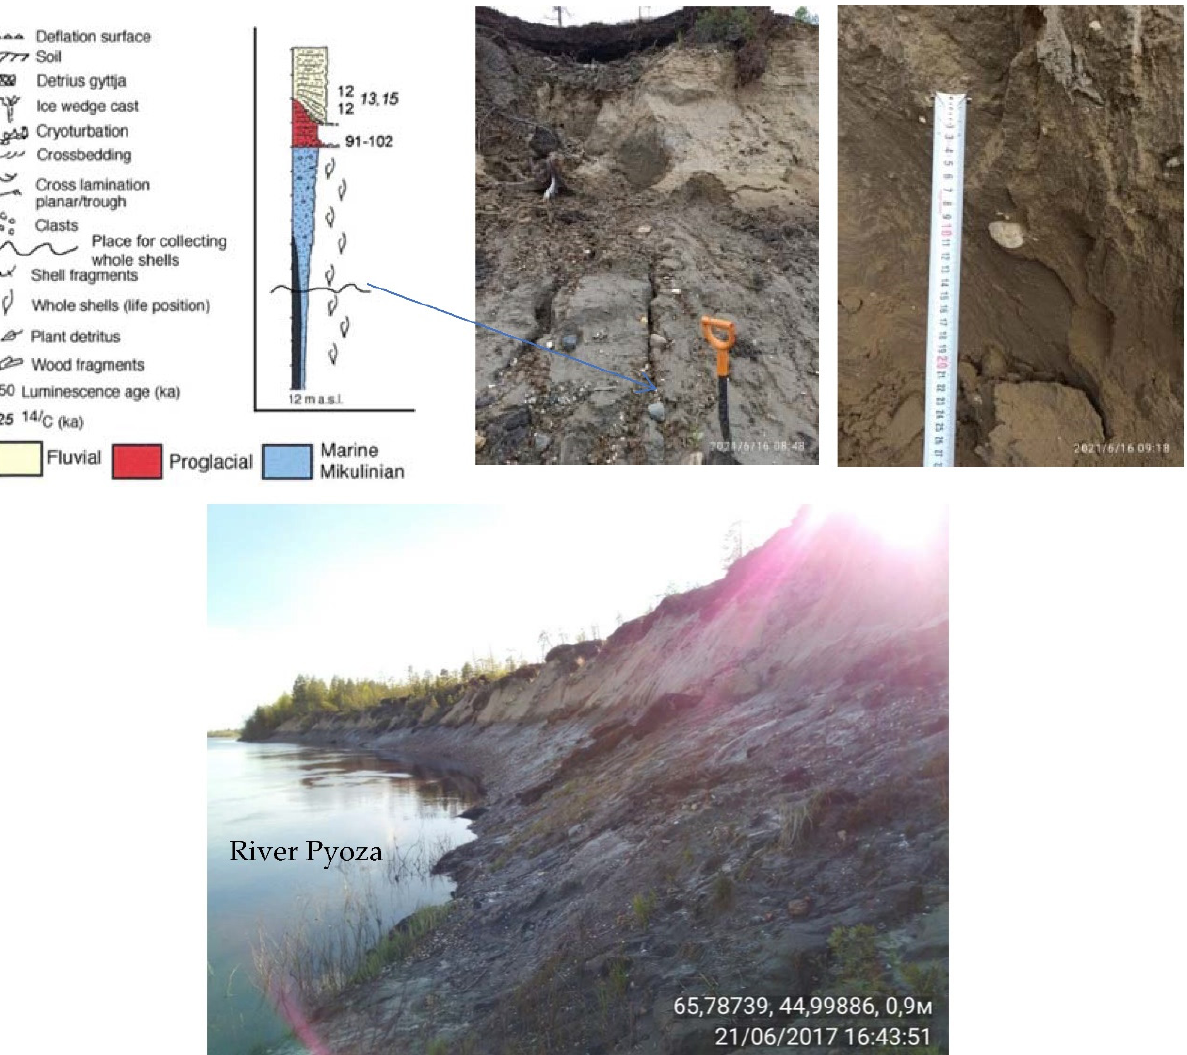
Figure 6. Lithological logs, lower Pyoza area (Bychye). Stratigraphic logs indicate thickness, lithology, structures, glaciodynamic properties, palaeocurrent patterns, fossils, and OSL and 14 C ages. The elevation in metres above present sea level of the base of each section (in most cases, the elevation of the Pyoza River bed) is indicated beneath each log. Regional stratigraphic units are identified by different colours and environmental interpretations and chronostratigraphic affiliation of units are indicated [71]. Curved pattern revealing mollusk shells.